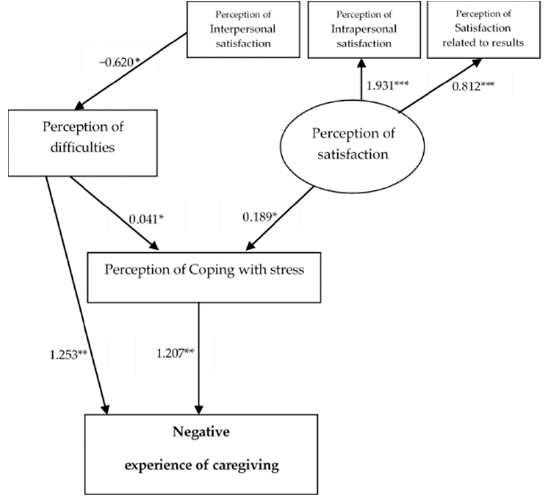
Figure 3. Standardized solutions of the accepted M1 model. Note: Only considered the significant estimates of regressive coefficients; * p < 0.05; ** p < 0.01; *** p < 0.001.